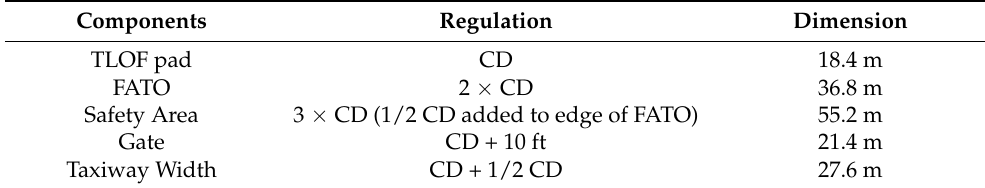
Table 1. Regulation and dimensions of primary vertiport components that comply with the FAA’s new regulations.